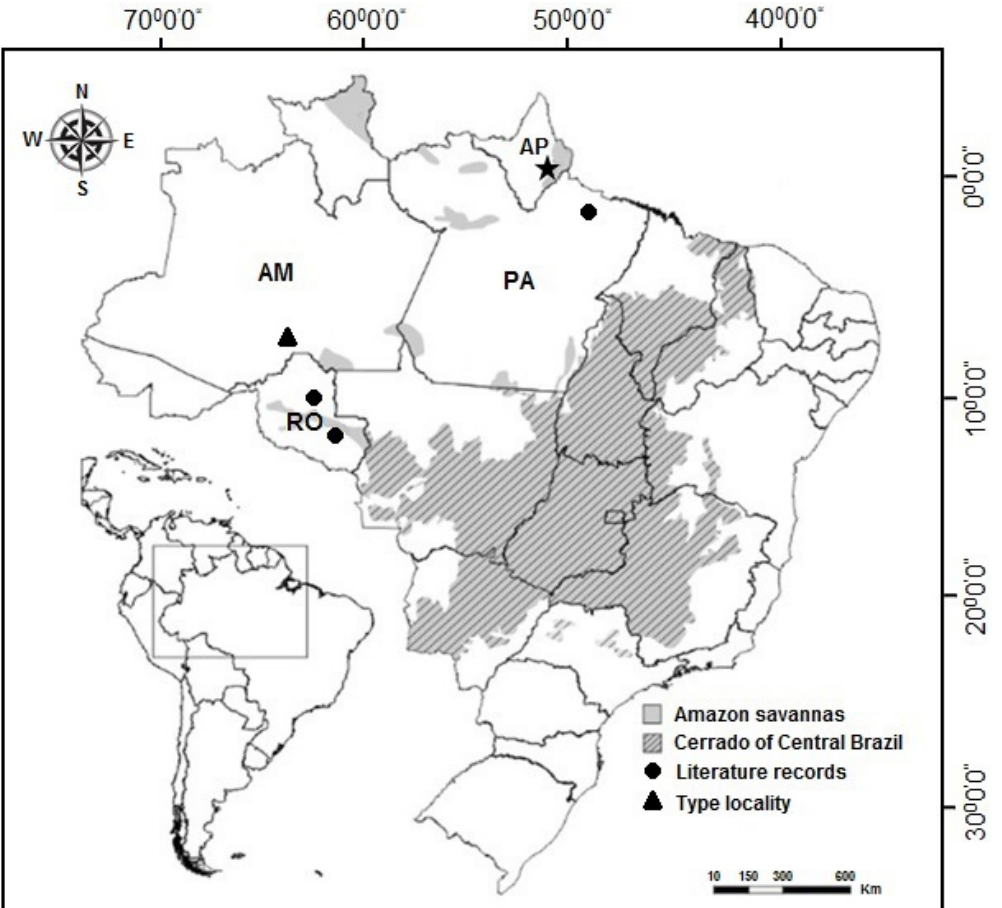
Figure 3. Known geographic distribution map of Elachistocleis helianneae . AM = Amazonas; RO = Rondônia; PA = Pará; AP = Amapá. Circles = localities cited in the literature data. Triangle = type locality. Star = new record in the municipality of Macapá, state of Amapá,